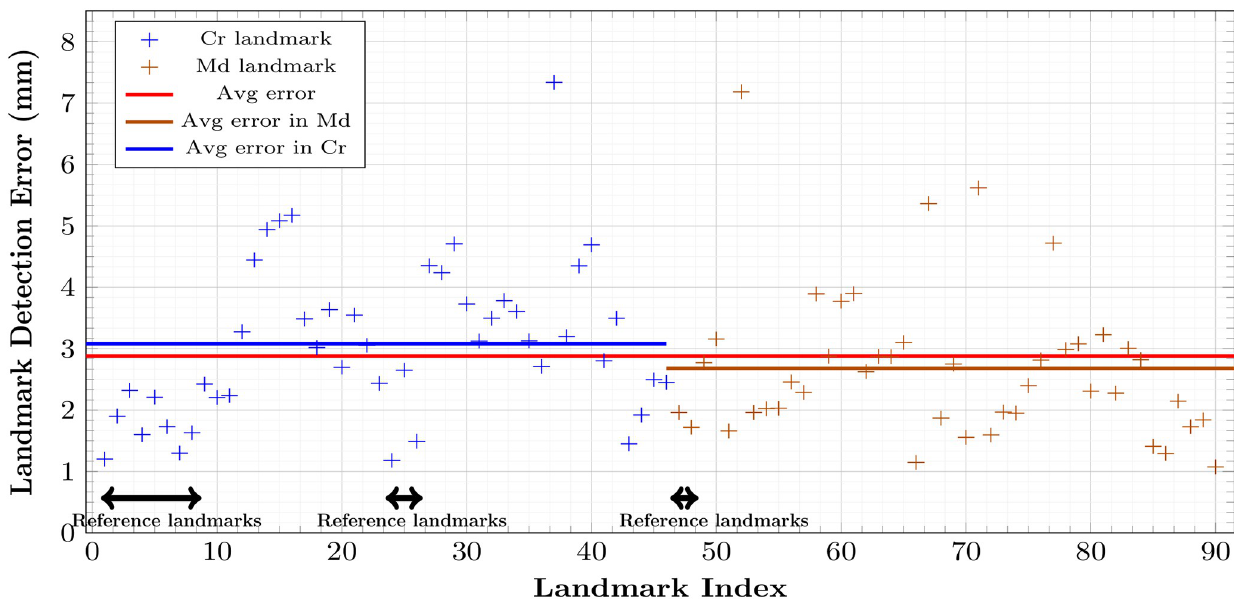
Fig 6. Final localization errors (mm) of 90 cephalometric landmarks after coarse-to-find detection over 9 test data. Blue and brown dots denote errors for cranial and mandibular landmarks, respectively. Red, blue, and brown lines represent average error over all, cranial, and mandibular landmarks.